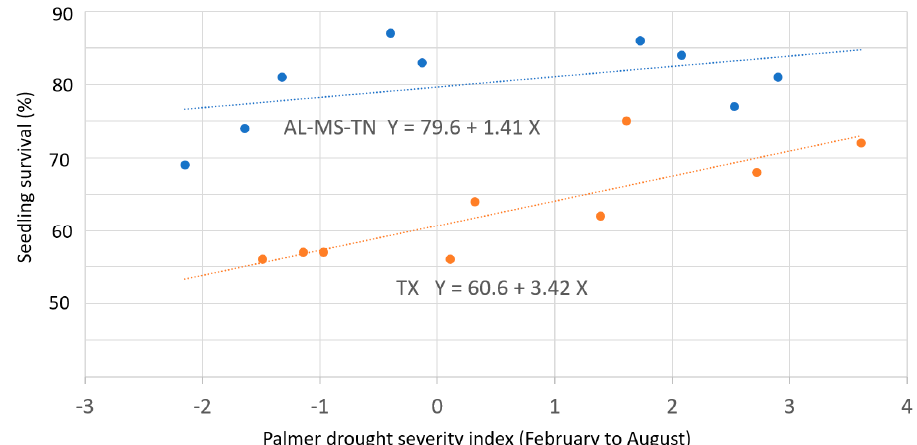
Figure 23. Survival of loblolly pine seedlings is related to the Palmer-Drought-Severity-Index (PDSI) calculated for the period of February to August. Data from [164]. Data from Alabama, Mississippi and Tennessee included company survival data from 690 locations and data from East Texas were obtained from a survey of 3570 sites. All seedlings were planted from 1983 to 1992 (one average per year). In East Texas, the year with the greatest survival (1989) had the highest rainfall (February to August—NOAA climate division 4; 130 mm/month; PDSI = 1.61). The year with the lowest rainfall in East Texas (1988) averaged 68 mm/month (PDSI = − 1.49). For East Texas, p > |t| = 0.0001 for intercept and 0.0047 for slope; R 2 = 0.70. For AL-TN-MS, p > |t| = 0.0001 for intercept and 0.21 for slope; R 2 = 0.21.